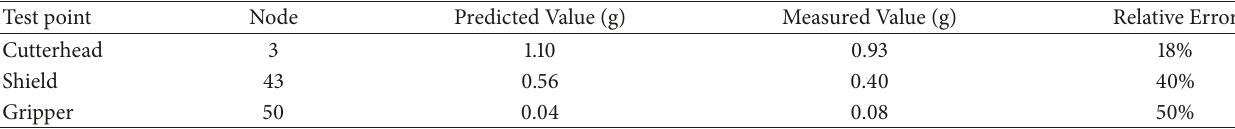
Table 2: Comparison of the measured and numerical results of the axial vibration accelerations.